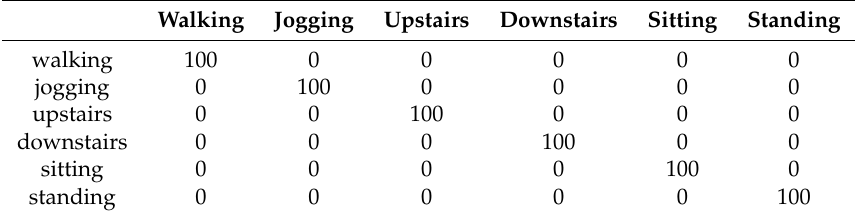
Table 6. Testing confusion matrix of the six single user activities.